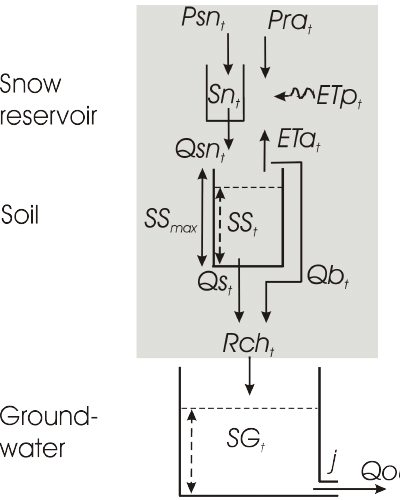
Fig. 1. Conceptual diagram of stores and fluxes controlling hy- drological drought development. Psn: precipitation as snow, Pra: precipitation as rain, Sn: snow storage, ETp: potential evapotran- spiration, ETa: actual evapotranspiration, Qsn: snowmelt, SS: soil water storage, SS max : total available soil moisture, Qs: downward flux across bottom of the soil (percolation), Qb: bypass flow, Rch: groundwater recharge, SG: groundwater storage, j : groundwater re- sponse parameter, and Qout: groundwater